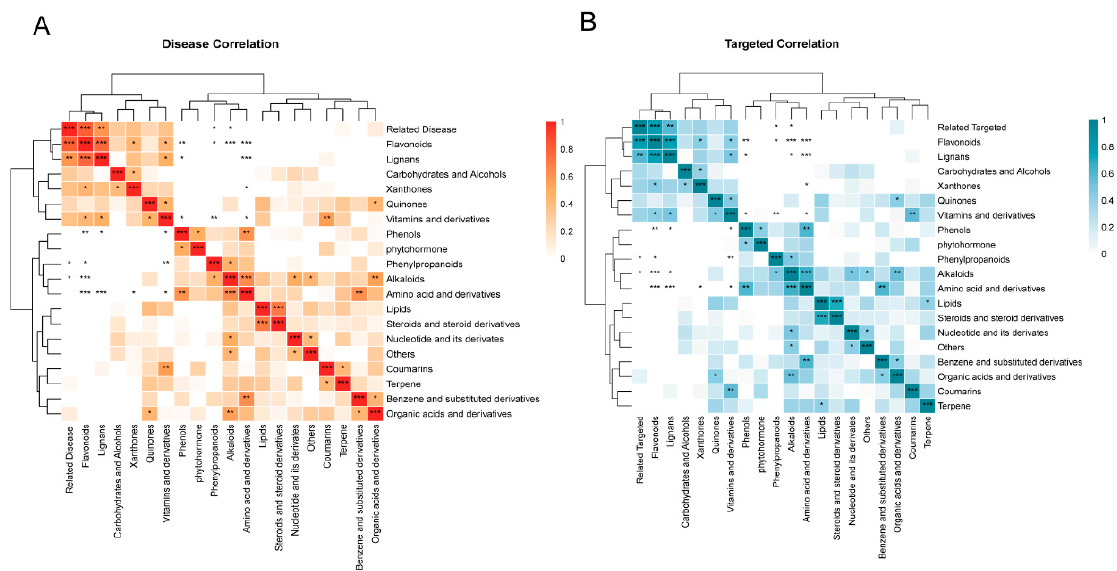
Figure 3. ( A ) Pearson correlation analysis between 19 compound classes and 326 related disease metabolites. ( B ) Pearson correlation analysis between 19 compound classes and 326 related targeted metabolites. * Significant correlation between different classes and diseases or targets, p < 0.05. ** Significant correlation between different classes and diseases or targets, p < 0.01. *** Significant correlation between different classes and diseases or targets, p < 0.001.